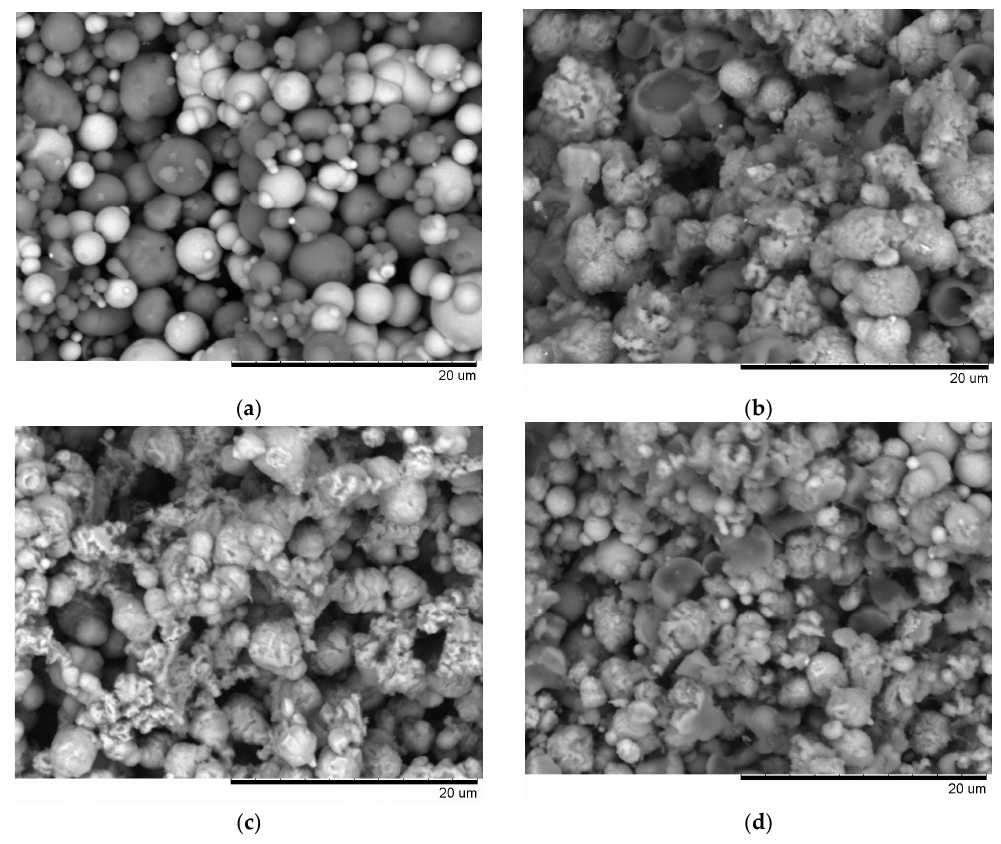
Figure 3. Fracture surface of porous compacts (BSE images) obtained from Fe-40at.%Al mixtures by pressureless SPS ( a ) 500 °C (green density 65%); ( b ) 600 °C; ( c ) 650 °C; ( d ) sintered in a pressureless experiment in the hot press at 650 °C.